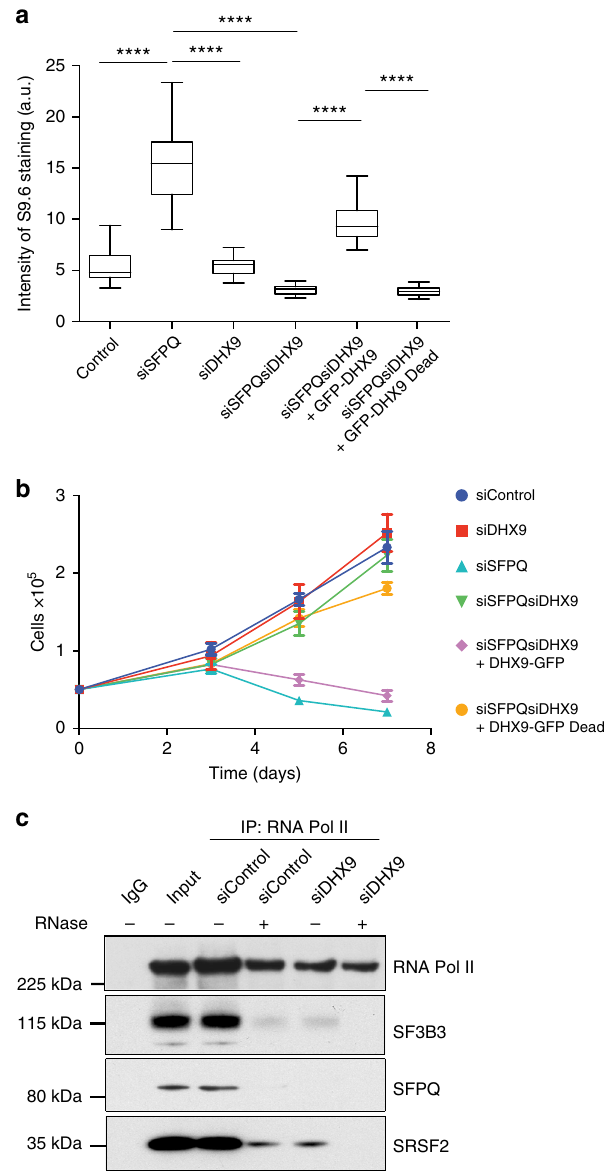
Fig. 7 DHX9 helicase activity is required for R-loop formation and growth inhibition. a Expression of wild-type DHX9, but not a helicase-defective mutant (pGFP-DHX9dead), promotes R-loop formation in SFPQ-defective cells. Fluorescence intensity of S9.6 staining was measured for n > 50